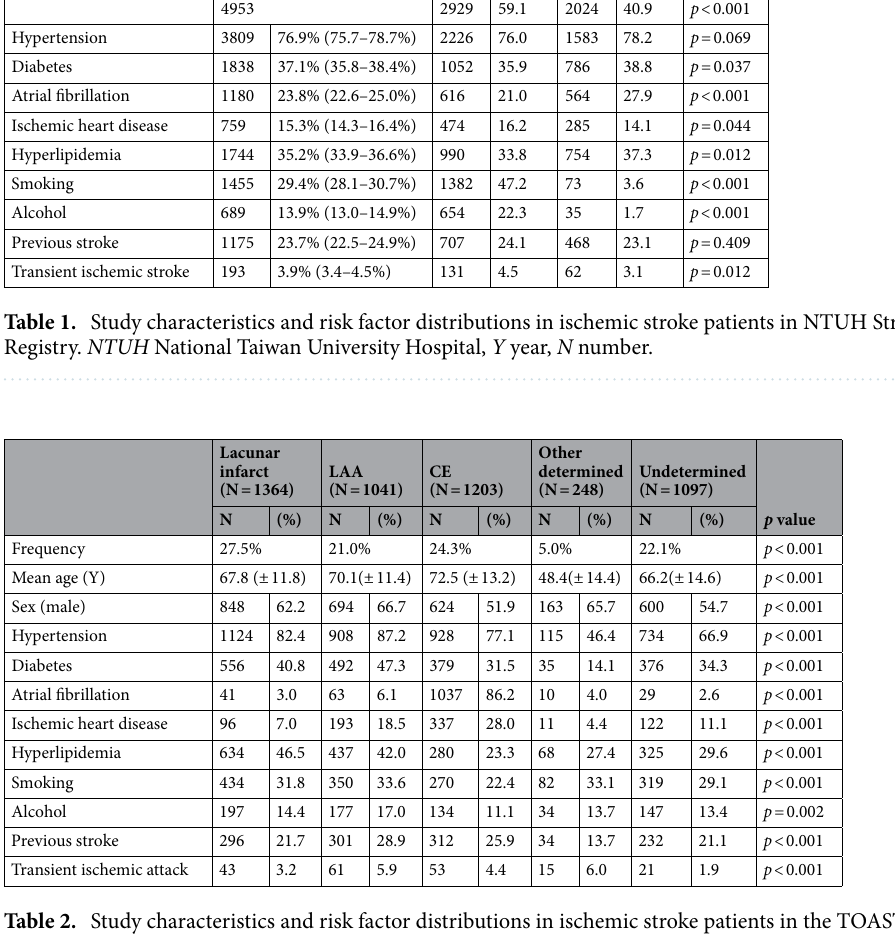
Table 2. Study characteristics and risk factor distributions in ischemic stroke patients in the TOAST classification. Y year, N number, LAA large artery atherosclerosis, CE cardioembolism.